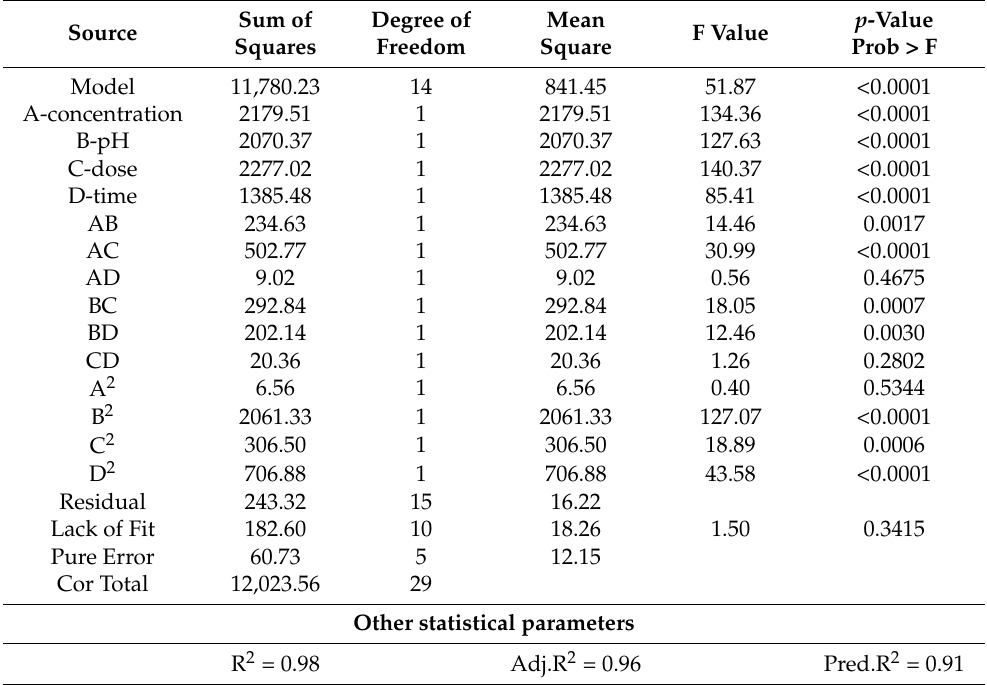
Table 5. ANOVA results of fluoride removal by PG.